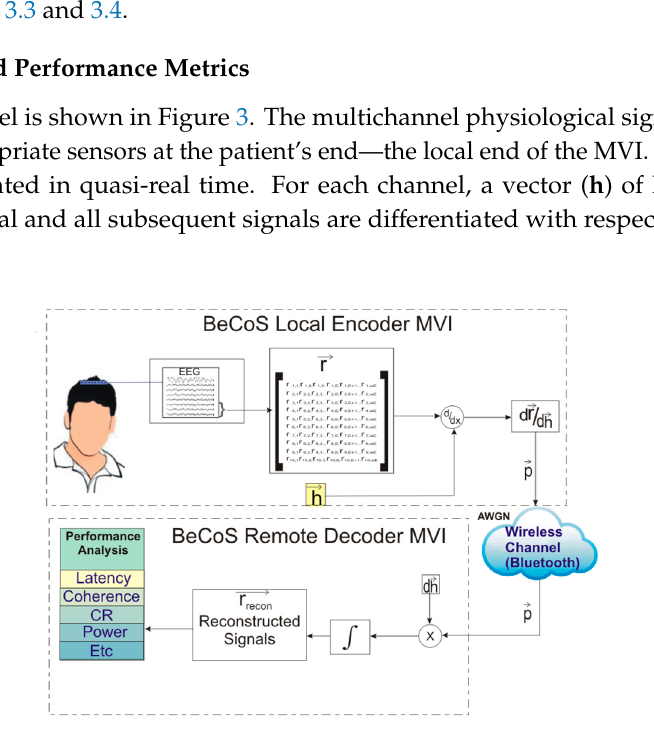
Figure 3. Conceptual diagram of the BeCoS system model.